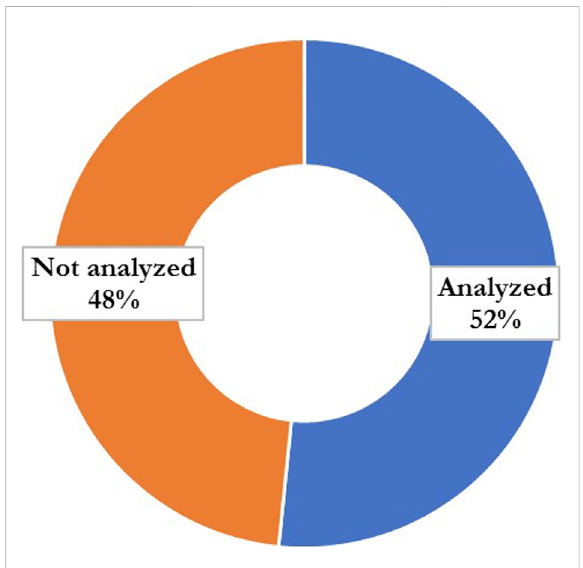
FIGURE 7 Share of studies analyzing investment costs. Source: Authors ’